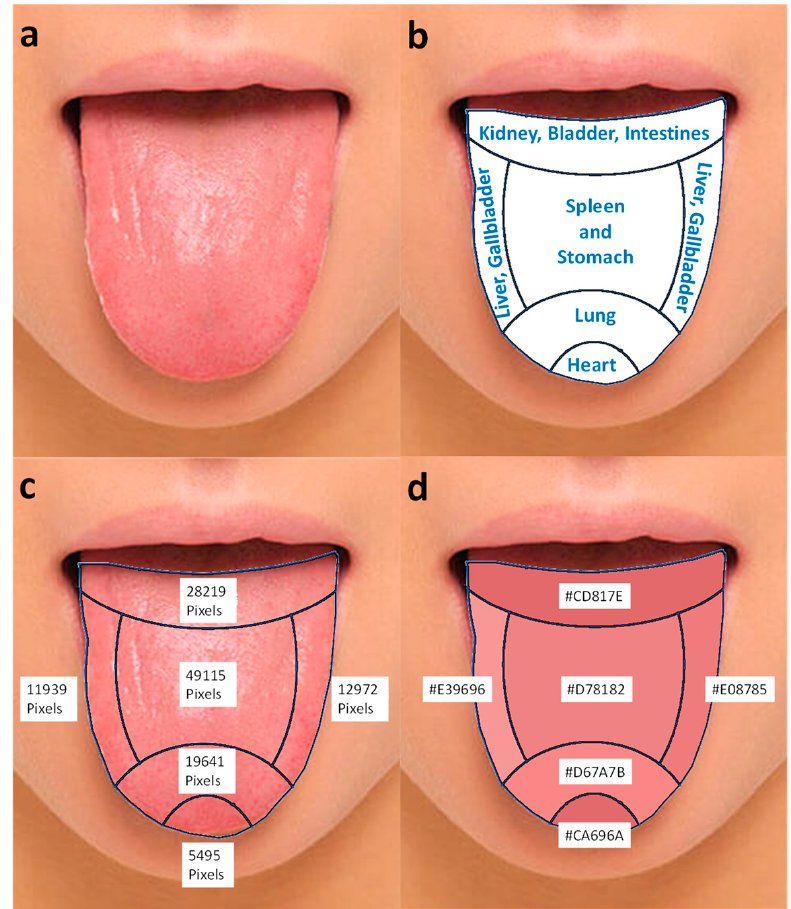
Figure 10. ( a ) A sample tongue photo of a patient, ( b ) a tongue chart used in oriental medicine, ( c ) areas of each section, and ( d ) a tongue repainted by representing average colors with corresponding hexadecimal color codes of individual sections of a tongue.